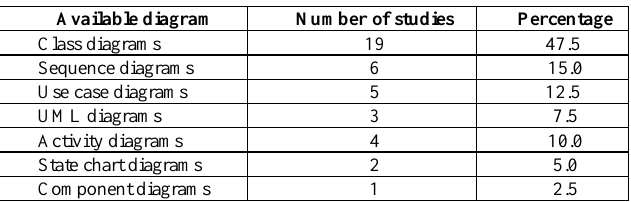
TABLE I R ESULTS PER T YPE OF D IAGRAM